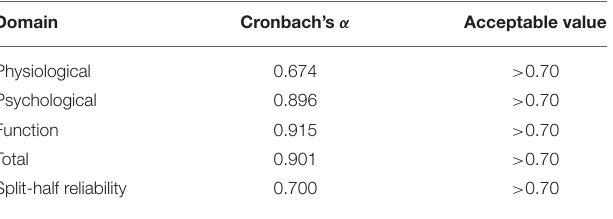
TABLE 3 | Reliability of the scale.